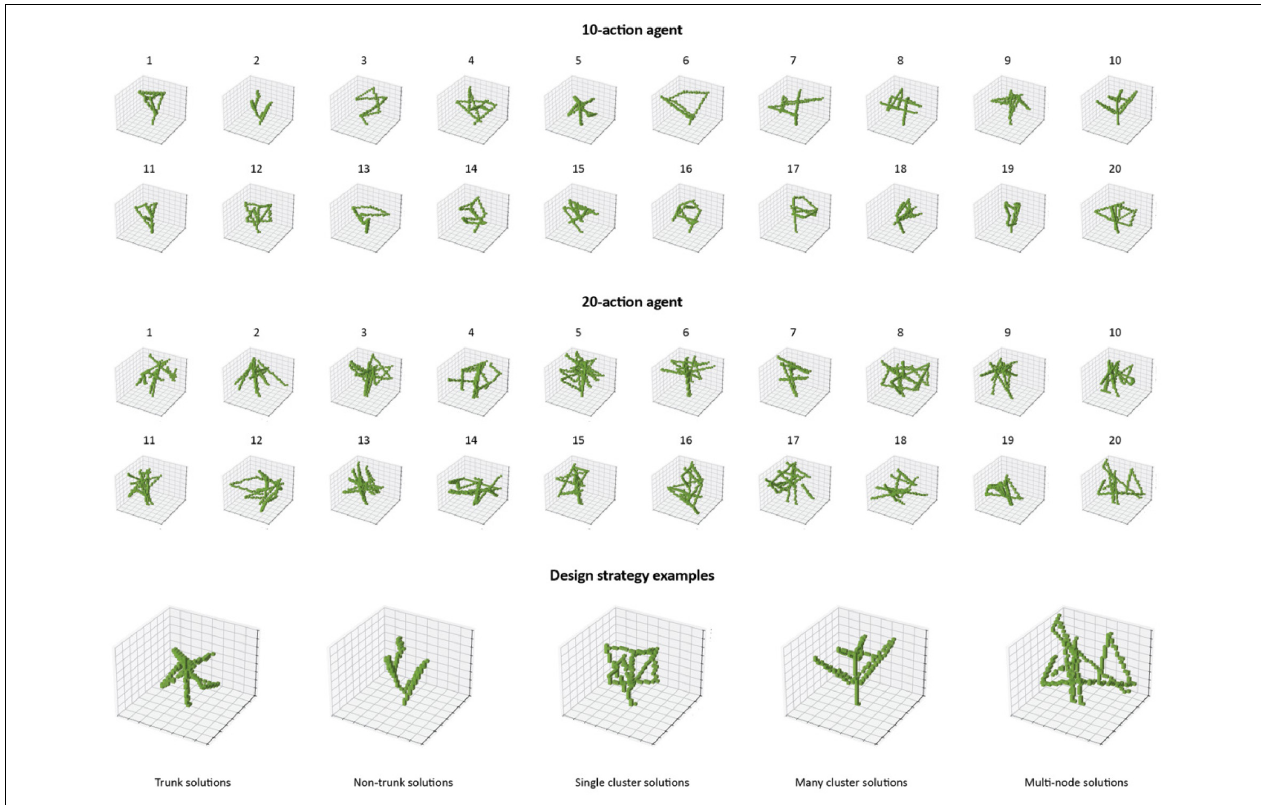
FIGURE 7 | Visual abstractions produced by the 10-actions agent and the 20-actions agent during the last training